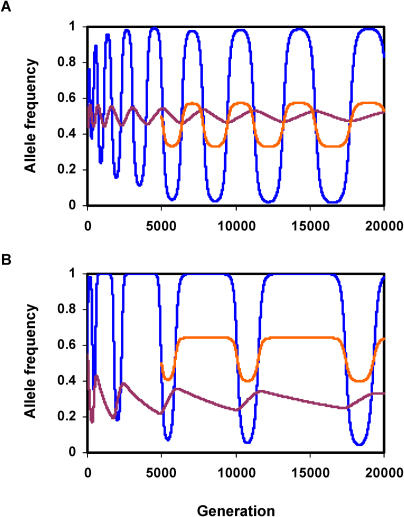
Co-Evolutionary Dynamics of Parasite Gene ExpressionIn both panels, the frequency of a modifier allele that increases the expression of the B allele in the parasite population is shown in orange. The frequency of the B allele in the parasite population is shown in blue, and the frequency of the A allele in the host population is shown in maroon. Both panels considered an expression modifier introduced at an initial frequency of 0.5 with the following effects: ρ
1[MM] = 0.75, ρ
1[Mm] = 0.50, ρ
1[mm] = 0.25, ρ
3[MM] = 0.25, ρ
3[Mm] = 0.5, ρ
3[mm] = 0.75, and ρ
2[i] = 1 − ρ
1[i] − ρ
3[i]. Parameters for the IMA model (A) were αh = 0.15, αp = 0.20, rh = 0.25, and rp = 0.25. Parameters for the GFG model (B) were γh = 0.15, γp = 0.20, Ch = 0.075, Cp = 0.10, ch = 0.0075, cp = 0.01, rh = 0.25, and rp = 0.25. In both panels, the initial frequency of the A allele and the B allele was 0.55.